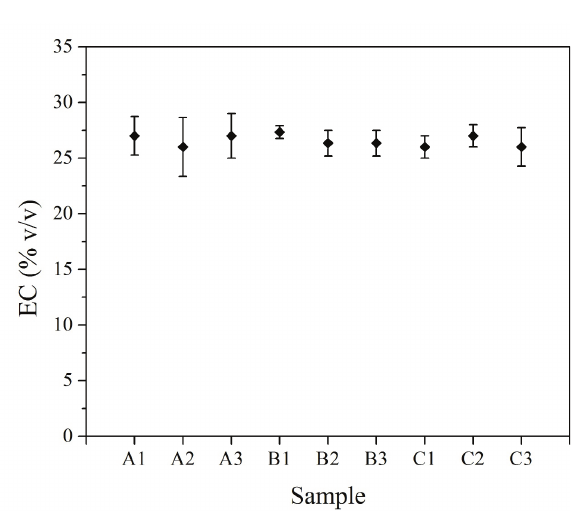
Fig. 1 – Results of anhydrous ethanol content using a 95 % confidence interval for the mean